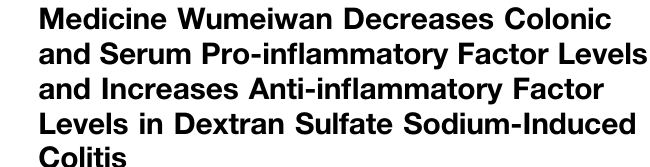
Frontiers in Pharmacology |